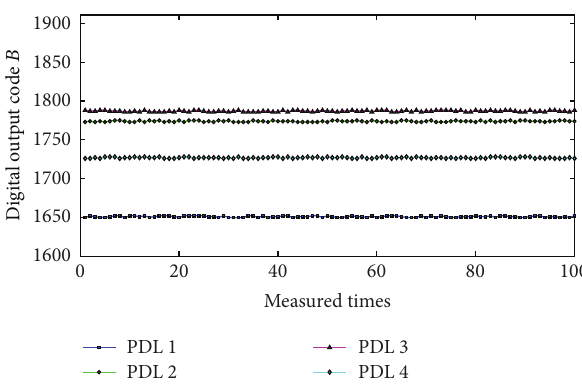
Figure 6: Measurement results of the proposed converter for four PDLs.